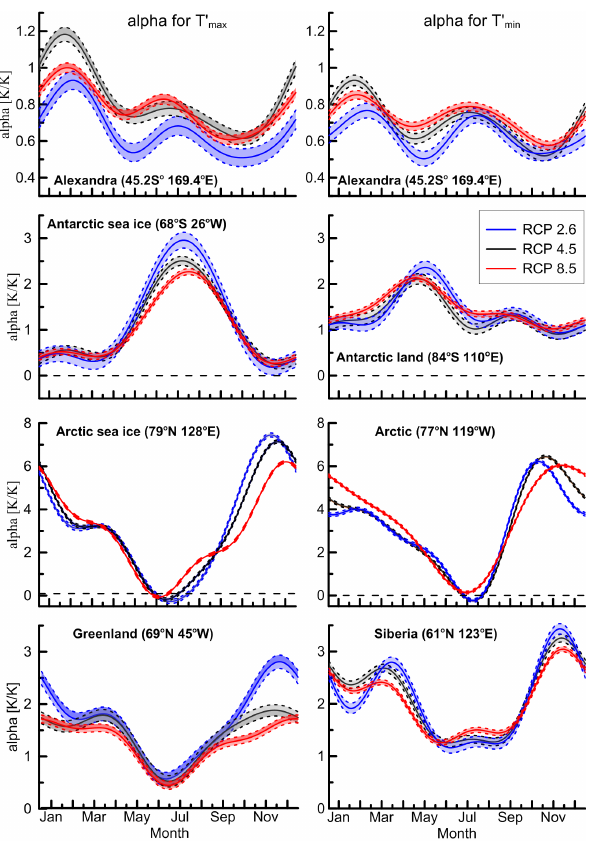
Fig. 8. α fit coefficients for T 0 max (left column) and T 0 min (right column) at seven selected sites (the Alexandra, New Zealand, site is examined for both T 0 max and T 0 min ) derived by fitting the regression model to output from three simulations of the HadGEM2-ES model based on the RCP emissions scenarios denoted in the legend. The solid lines show the regression model coefficients while the shaded regions bordered by dashed lines show the 1 σ uncertainties on the fit coefficients. The horizontal dashed black line marks the zero line. Note the different scales on the y